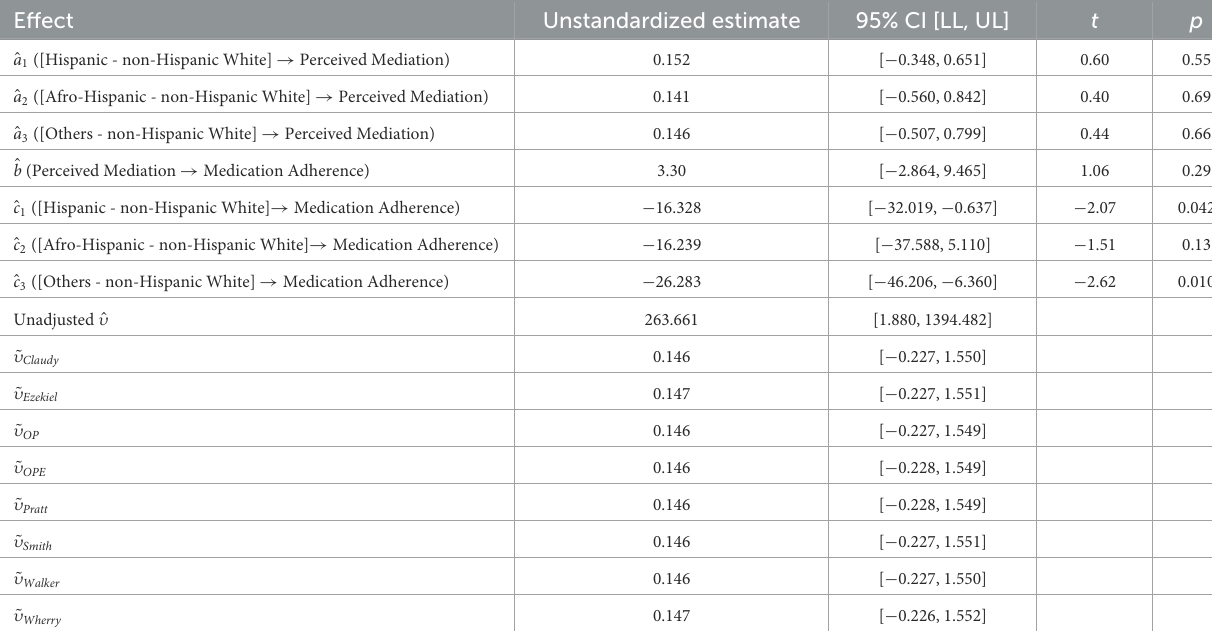
TABLE 4 Estimates of υ for mediation model in empirical example.